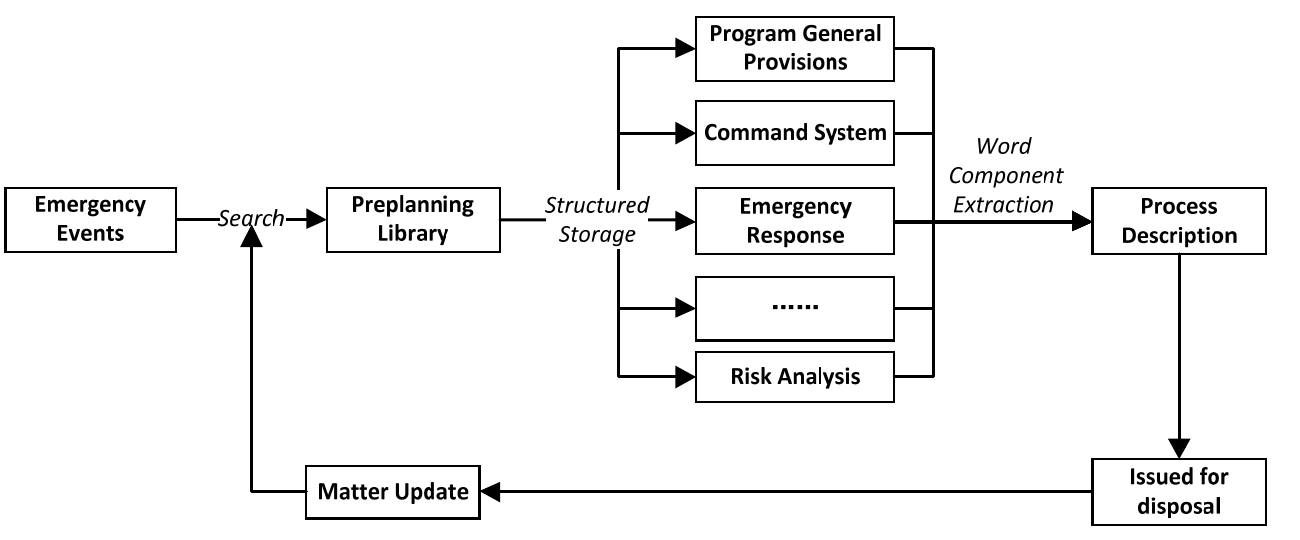
Figure 2. Digital plan construction technical frame diagram.